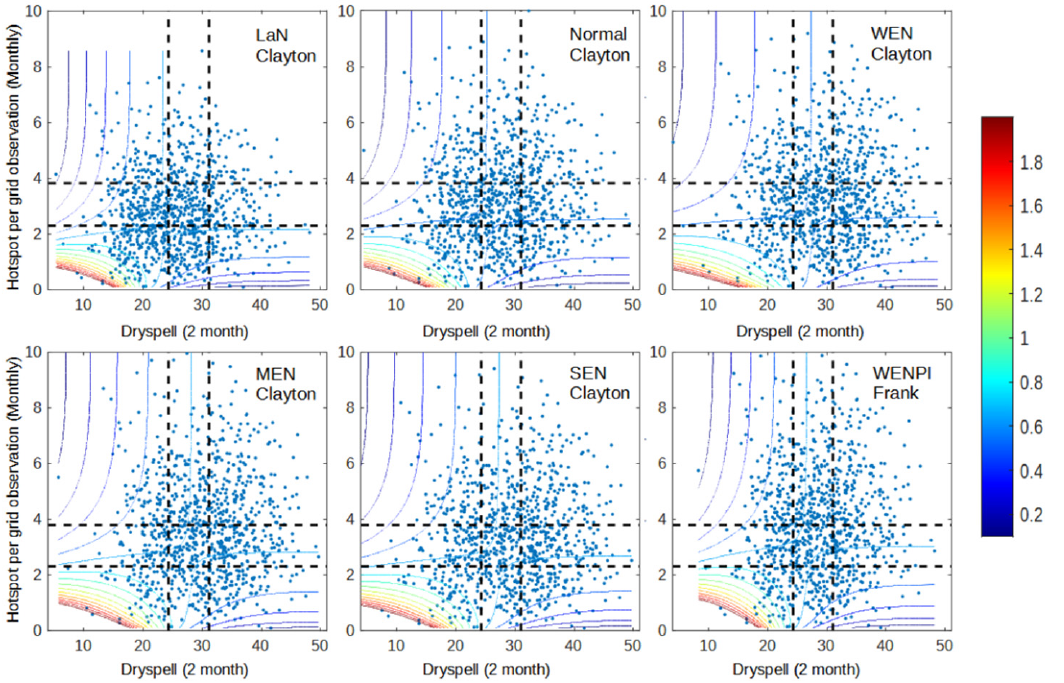
Figure 8. Dependency graph of dry spell and hotspot for 2001–2020 data. The dashed lines represent the separation of wet ( bottom / left ), normal ( middle ), and dry ( up / right ) conditions for dry spell (vertical line) and hotspot (horizontal line).